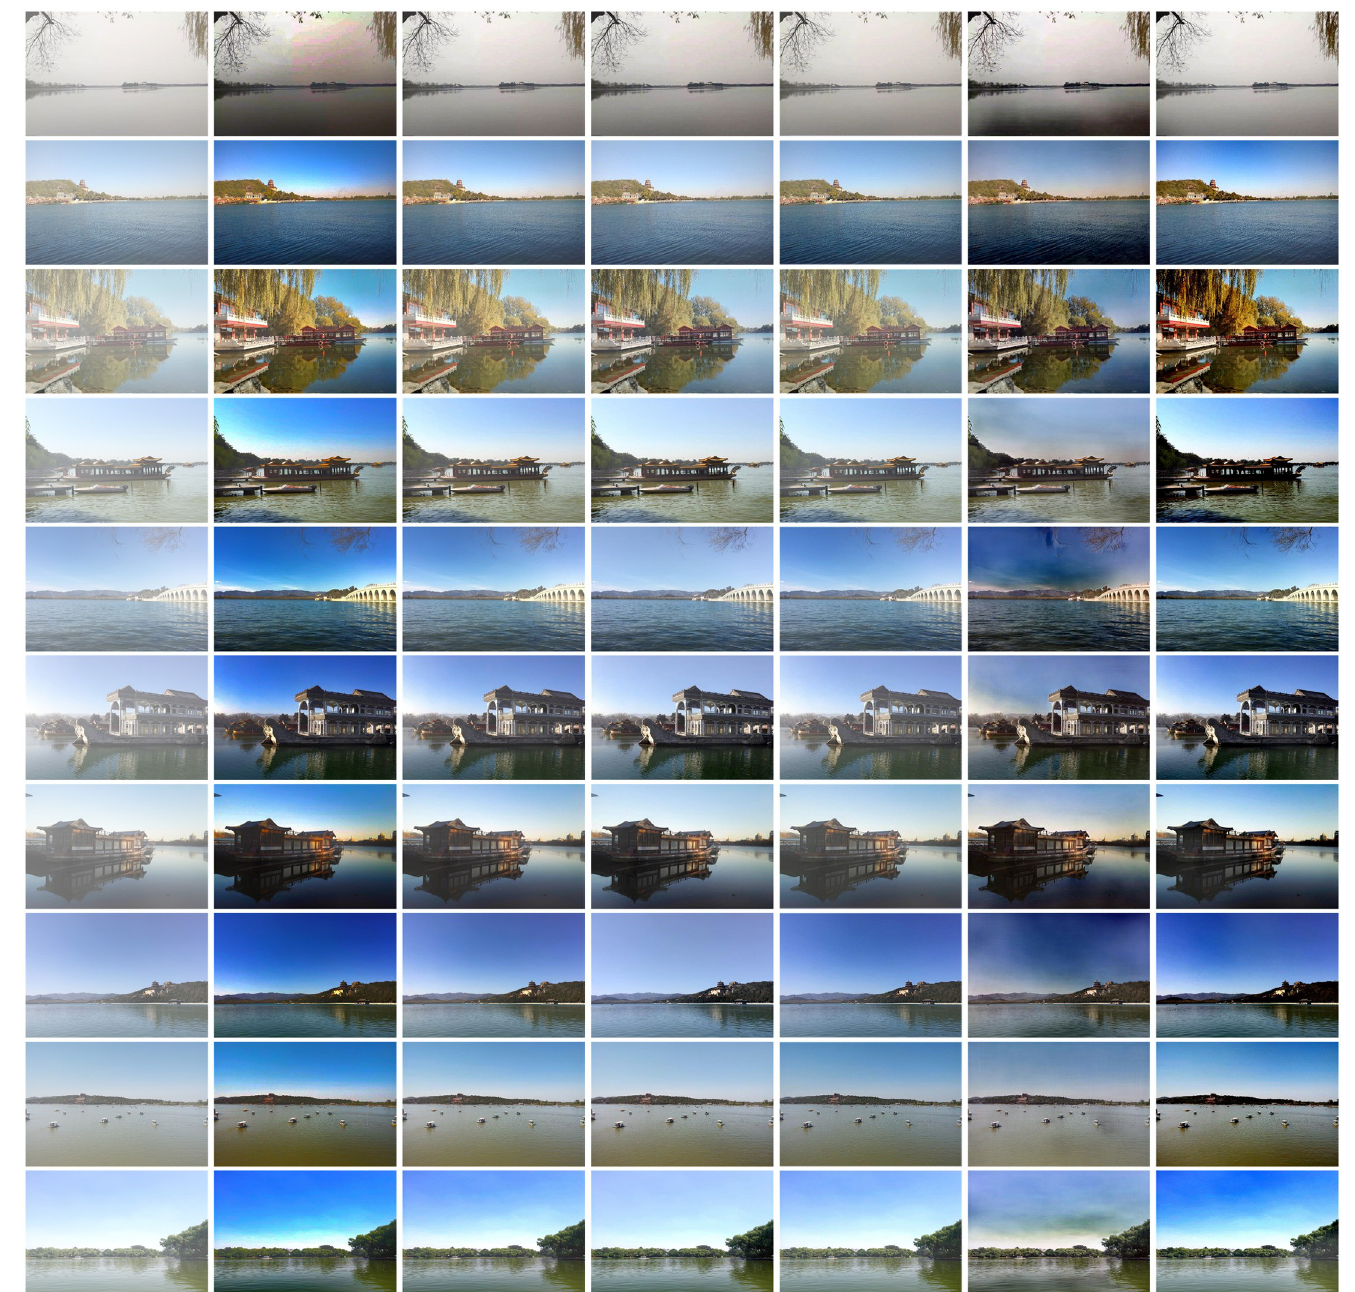
Fig 7. Qualitative comparison of different methods on synthetic images. From the left to the right column (i.e., Fig 7(a)–7(g)), the input hazy image, DCP [1], CAP [2], DehazNet [4], AOD-Net [5], GCAN [10], and our result).